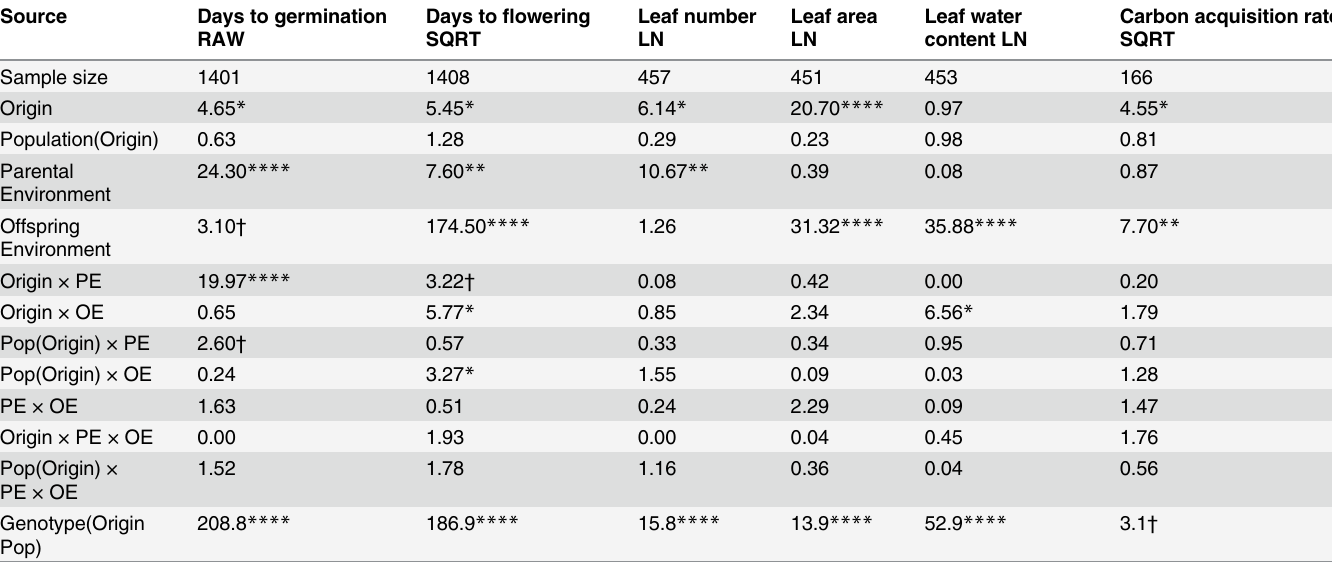
Table 2. Results of mixed-model analysis of variance results on traits associated with mechanisms of salinity avoidance and tolerance.